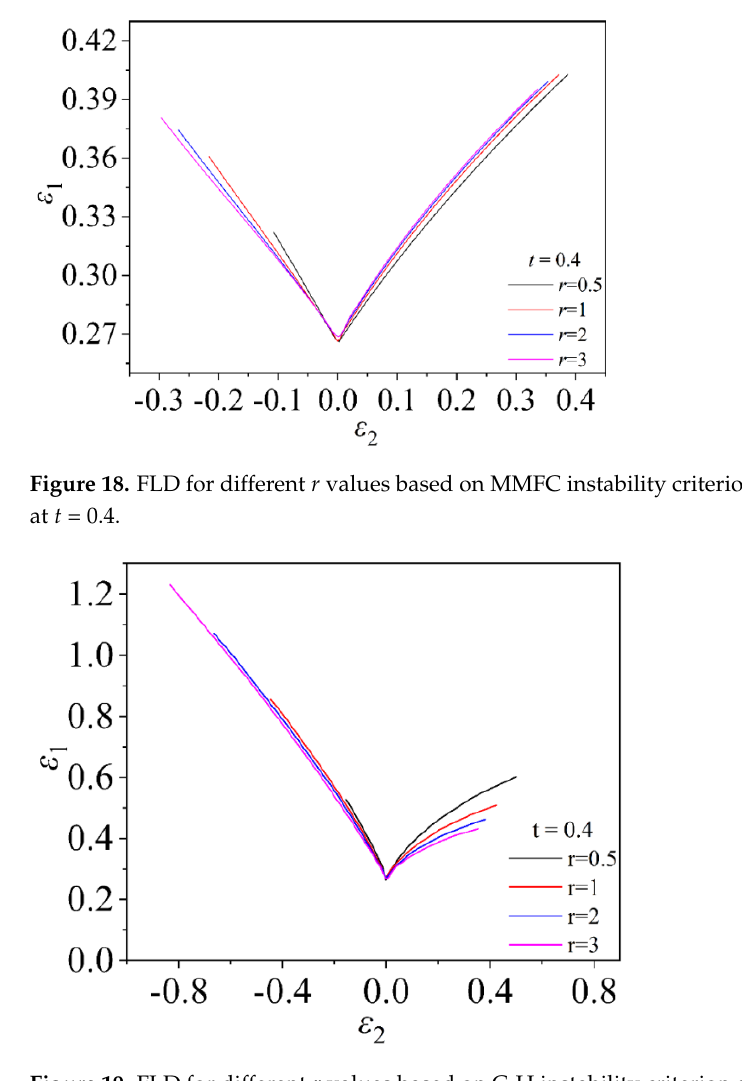
Figure 18. FLD for different r values based on MMFC instability criterion and Hill48 yield crite- rion at t = 0.4. Figure 19. FLD for different r values based on C-H instability criterion and Hill48 yield criterion at t =